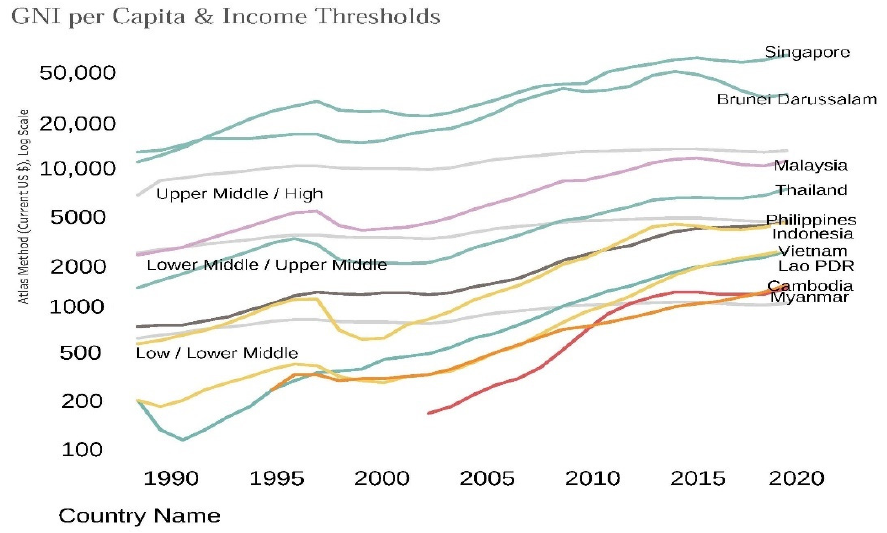
Figure 1. ASEAN’s income sub-groups on the basis of GNI per capita. Source: ESCAP (based on World Economic Outlook databases).